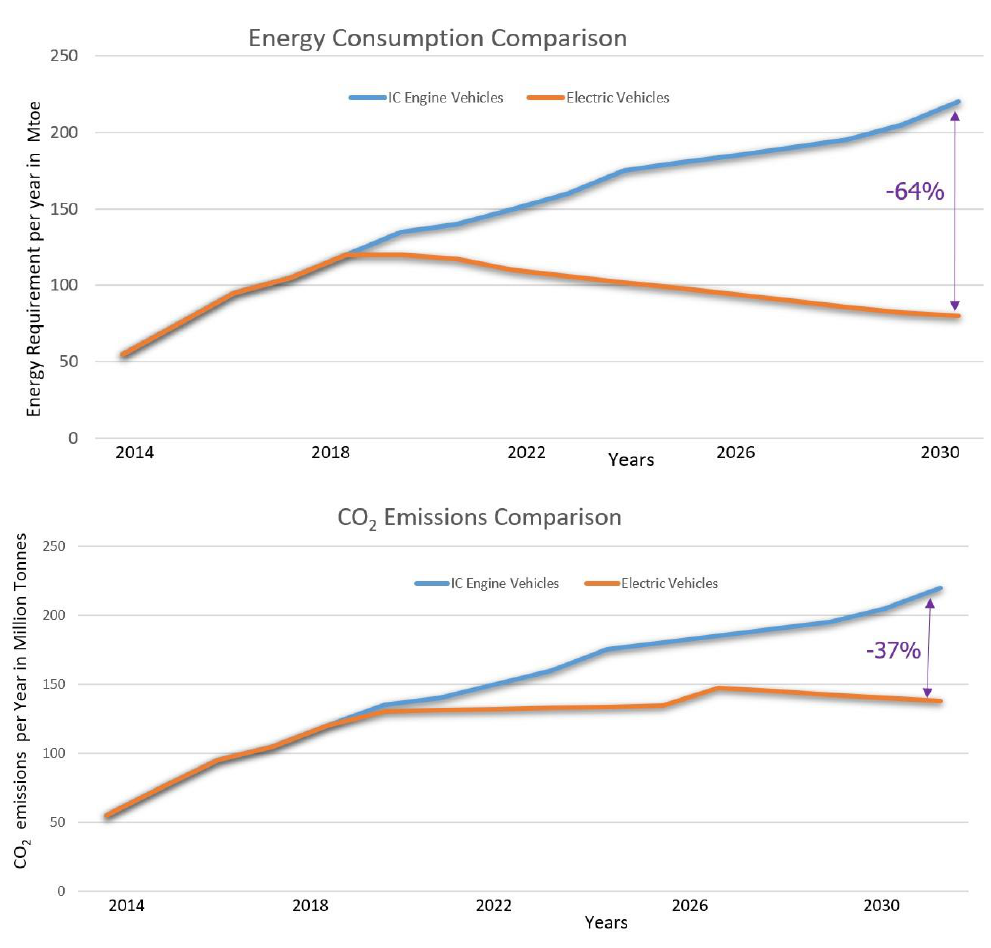
Figure 4. The variations of energy requirements and CO 2 emissions over the years.